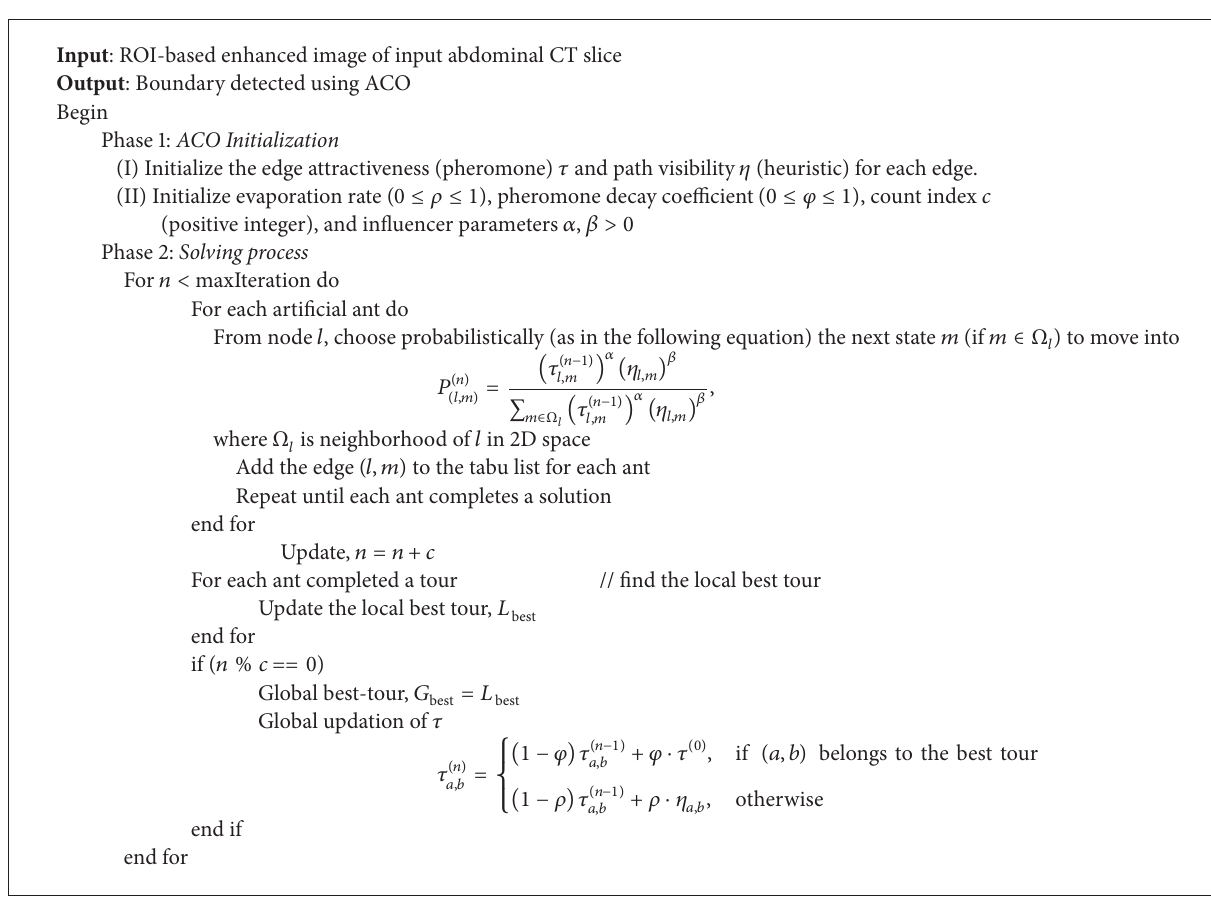
Algorithm 1: Variant ACO